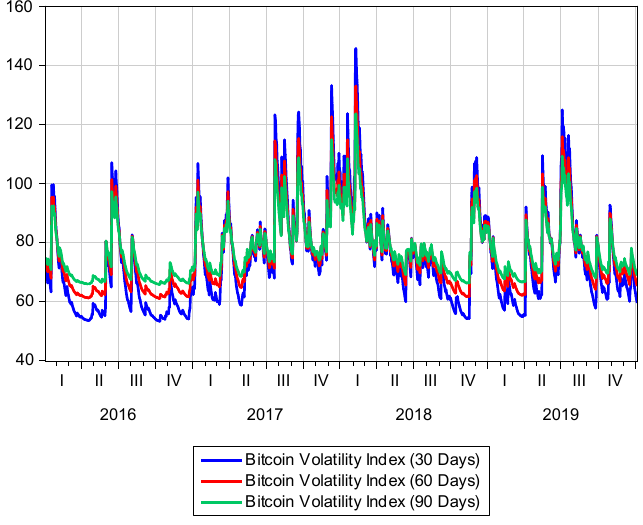
Figure 4. BTCUSD GARCH(1,1) Volatility indices.